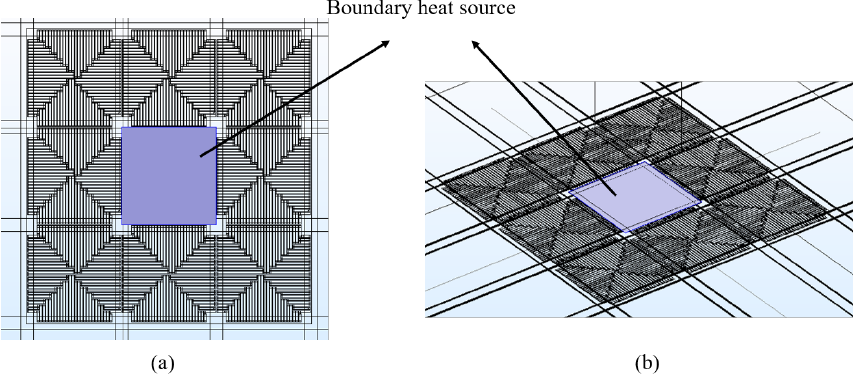
Figure 6. ( a ) Top view of the boundary heat source area. ( b ) 3D view of the boundary heat source area. The crosstalk simulated with the uniform heat source (3.02%) is slightly higher than that simulated with Joule heating (2.7%), while the responsivity shows an opposite trend, i.e., 13% lower. This is expected, as a non-uniform heat distribution across the pixel enhances ∆ T , while inter-pixel heat diffusion is limited by the localised thermopile